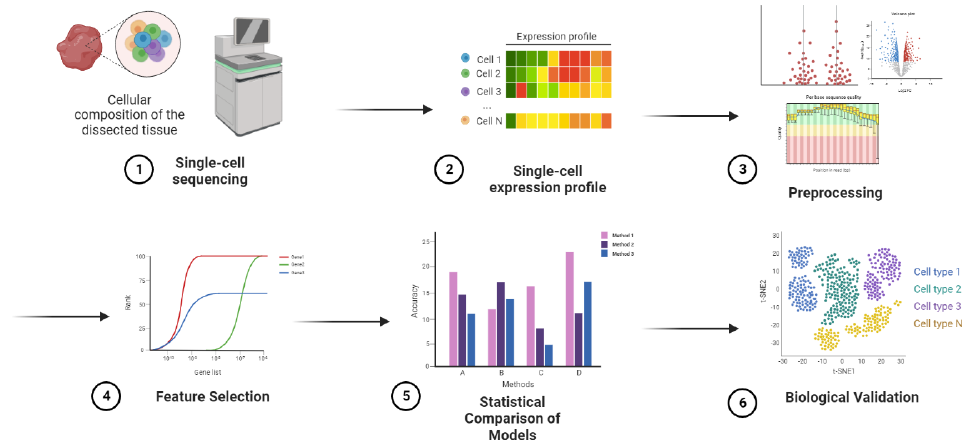
Figure 1. Pipeline overview of the